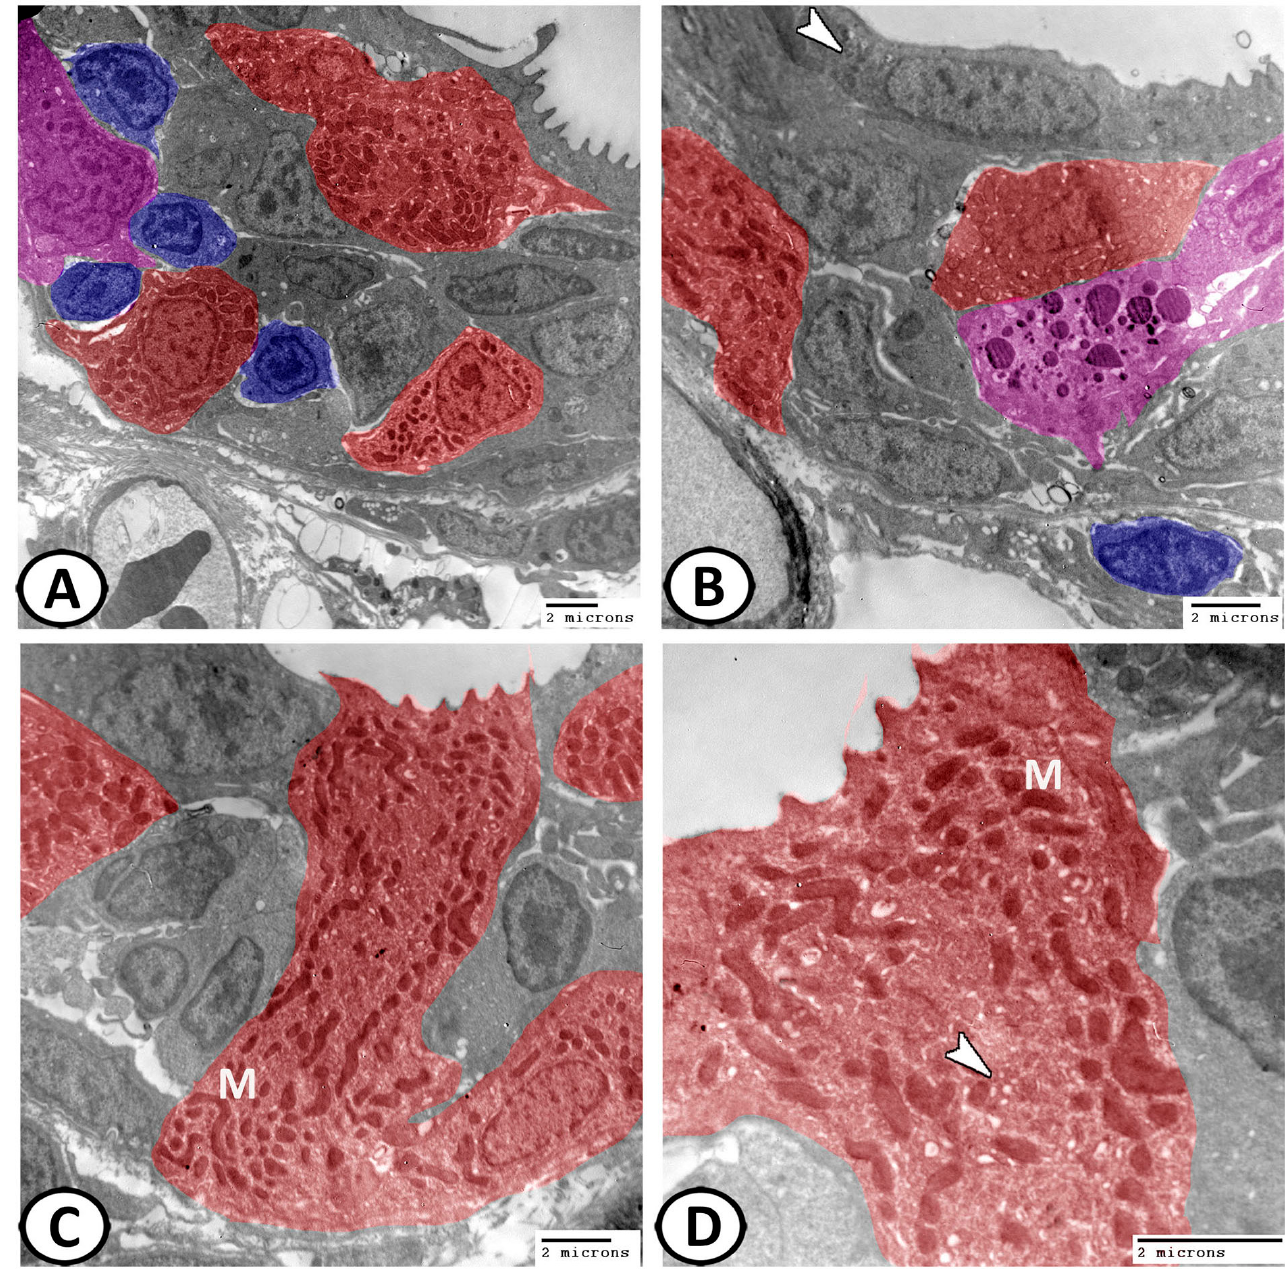
Figure 8. Digital colored TEM images of gills. ( A ) Primary gill lamellae contained chloride cells (red), lymphocytes (blue), and macrophages (pink). ( B ) Primary gill lamellae showed apical PVC (arrowhead), chloride cell (red), lymphocytes (blue), and neuroepithelial cells with electron-dense granules (pink). ( C , D ) Chloride cells (red) contained mitochondria (M), and a tubulovesicular system (arrowhead).